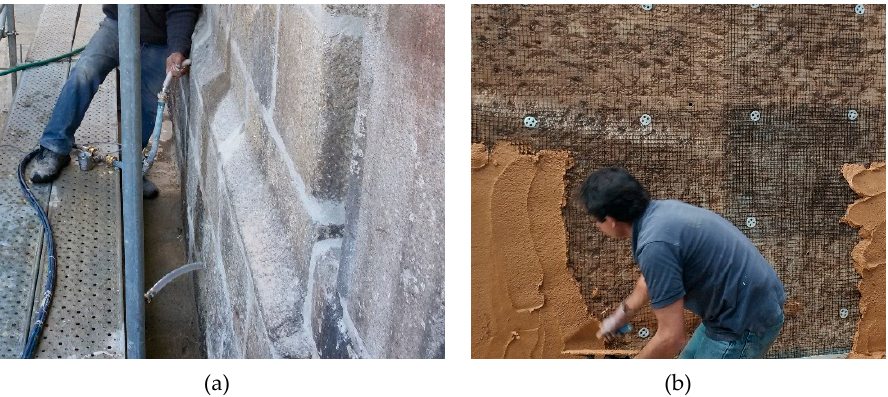
Figure 8. Examples of innovative strengthening solutions: ( a ) grout injection and ( b ) textile-reinforced mortar (TRM).